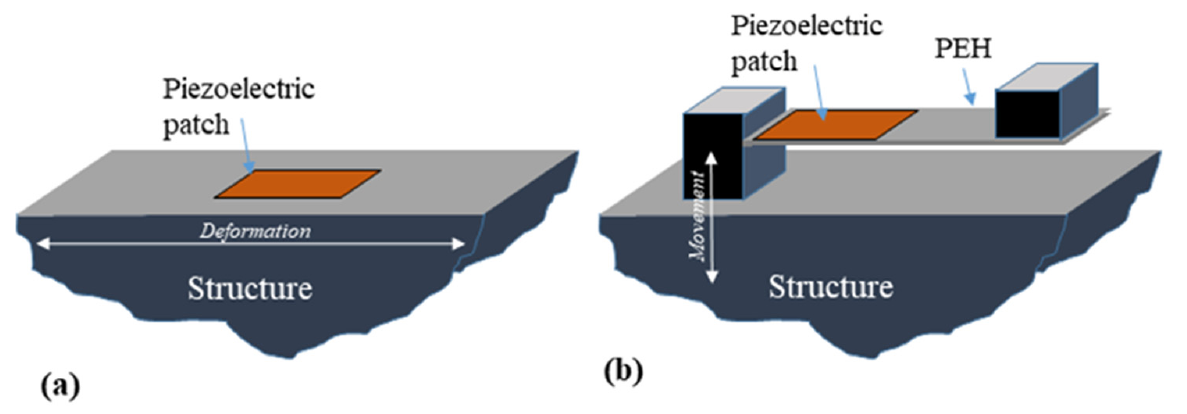
Figure 3. Piezoelectricity energy harvesting systems ( a ) bonded piezoelectric material ( b ) piezoelectric cantilever beam attached to the system.